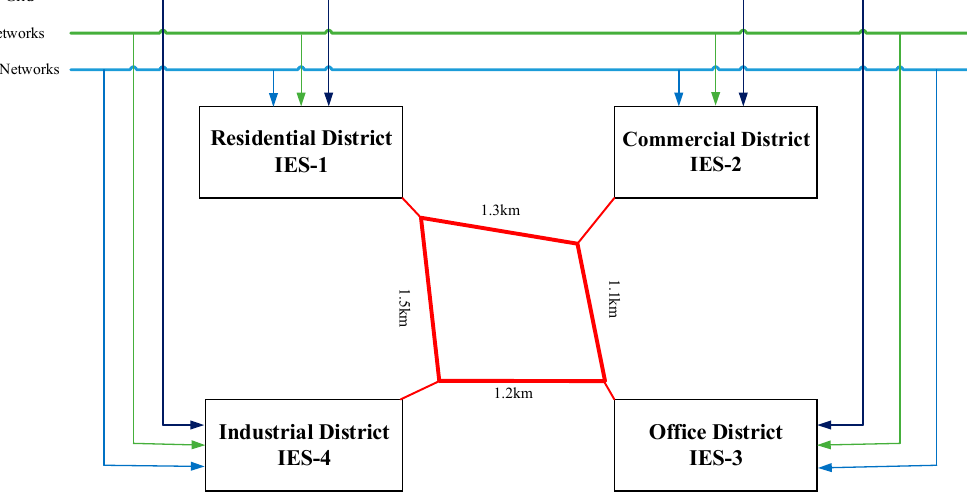
Figure 5. Coupling structure between the multi-district IES and the heating network. Table 2. Capacities of devices in each sub-district.